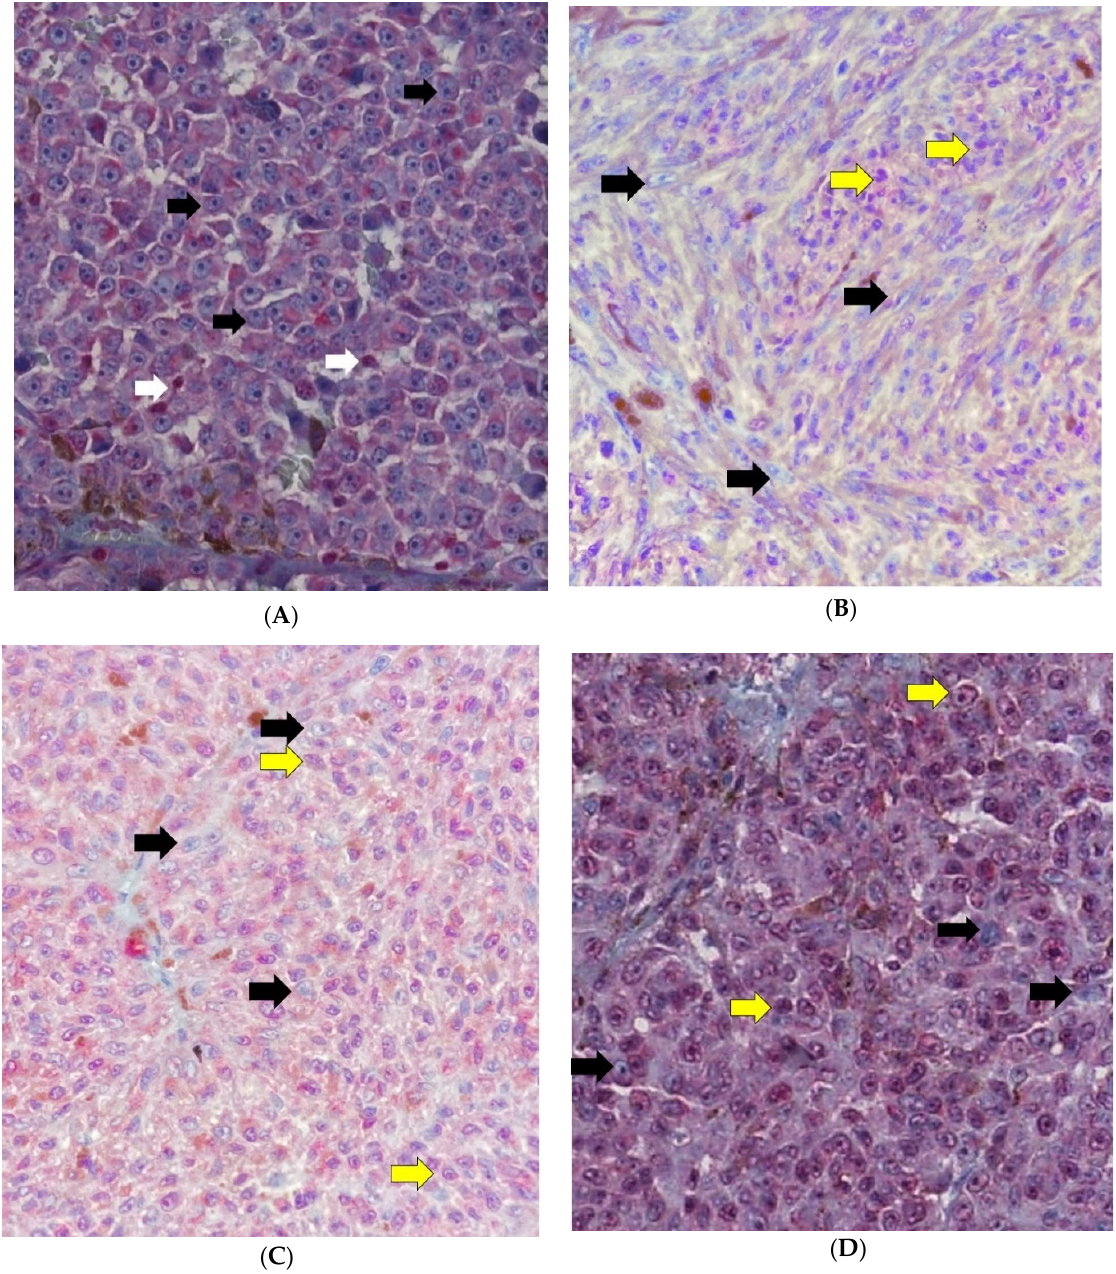
Figure 2. Nuclear BAP1 staining. ( A ) Grade 0 = positive staining in less than 10% of cells per high-power field (×400). Negative nuclear stain (black arrows) and lymphocytes used as positive control (white arrow). ( B ) Grade 1 = positive staining between 10% and 33% of cells per high-power field (×400). Negative nuclear stain (black arrows) and positive nuclear stain (yellow arrows). ( C ) Grade 2 = positive staining between 34% and 66% of cells per high-power field (×400). Negative nuclear stain (black arrows) and positive nuclear stain (yellow arrows) ( D ) Grade 3 = positive staining in ≥ 66% of cells per high-power field (×400). Negative nuclear stain (black arrows) and positive nuclear stain (yellow arrows).